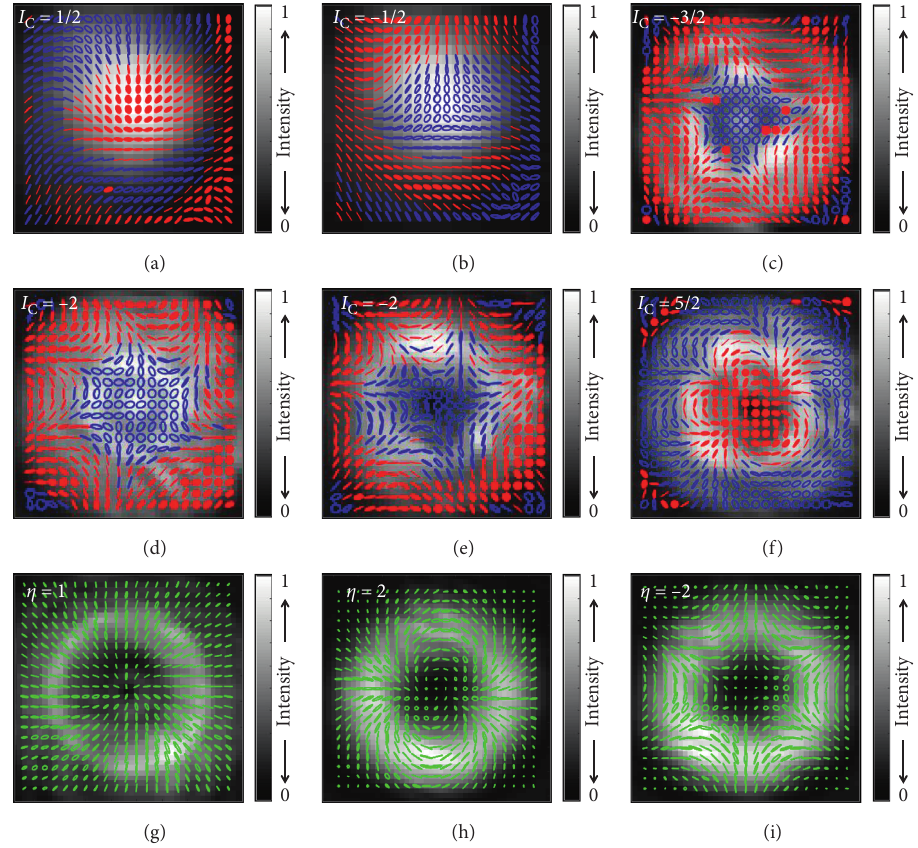
Figure 11: Experimentally recorded polarization distributions containing (a–f) C-points and (g–i) V-points. Indices of C-points and V- points are mentioned above each figure. (a–d) Bright C-points; (e-f) dark C-points. V-points always occur at intensity null. (g) A generic V- point; (h) a polarization flower; (i) a spider